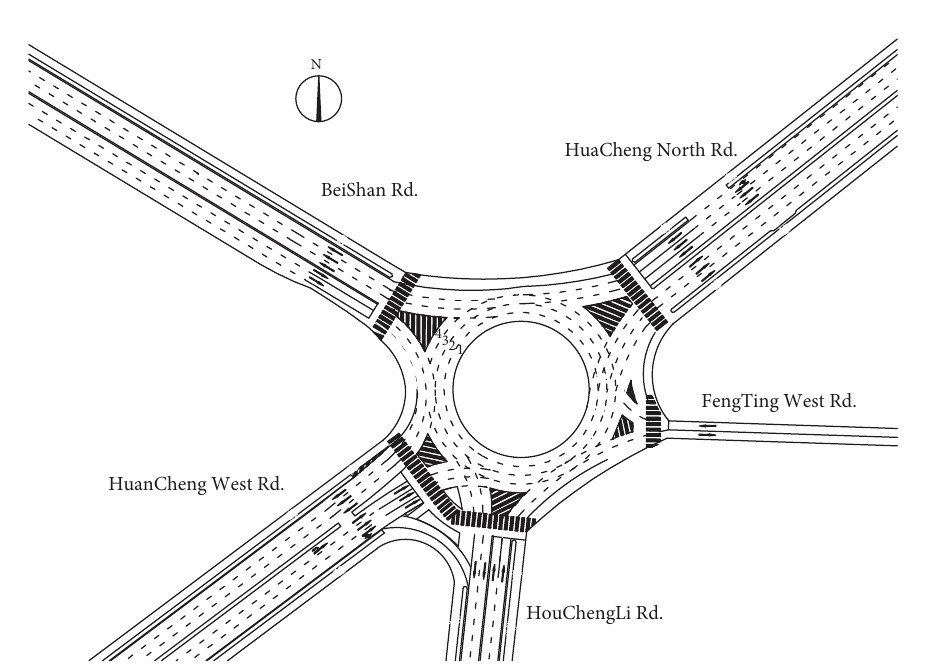
Figure 7: Optimized trafc organization of the target